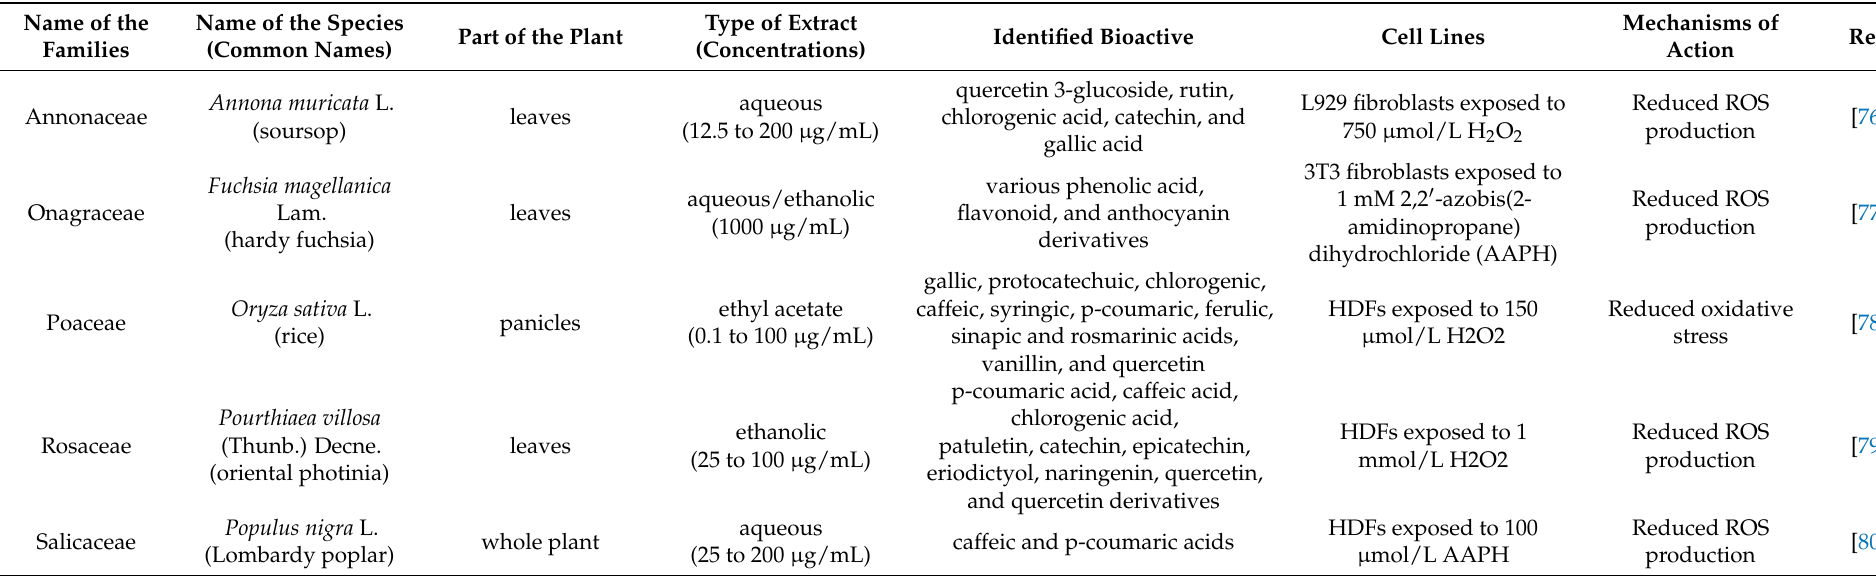
Table 1. Selected plant extracts from different species with identified phenolic compounds and their in vitro effect on dermal fibroblast cells and ROS